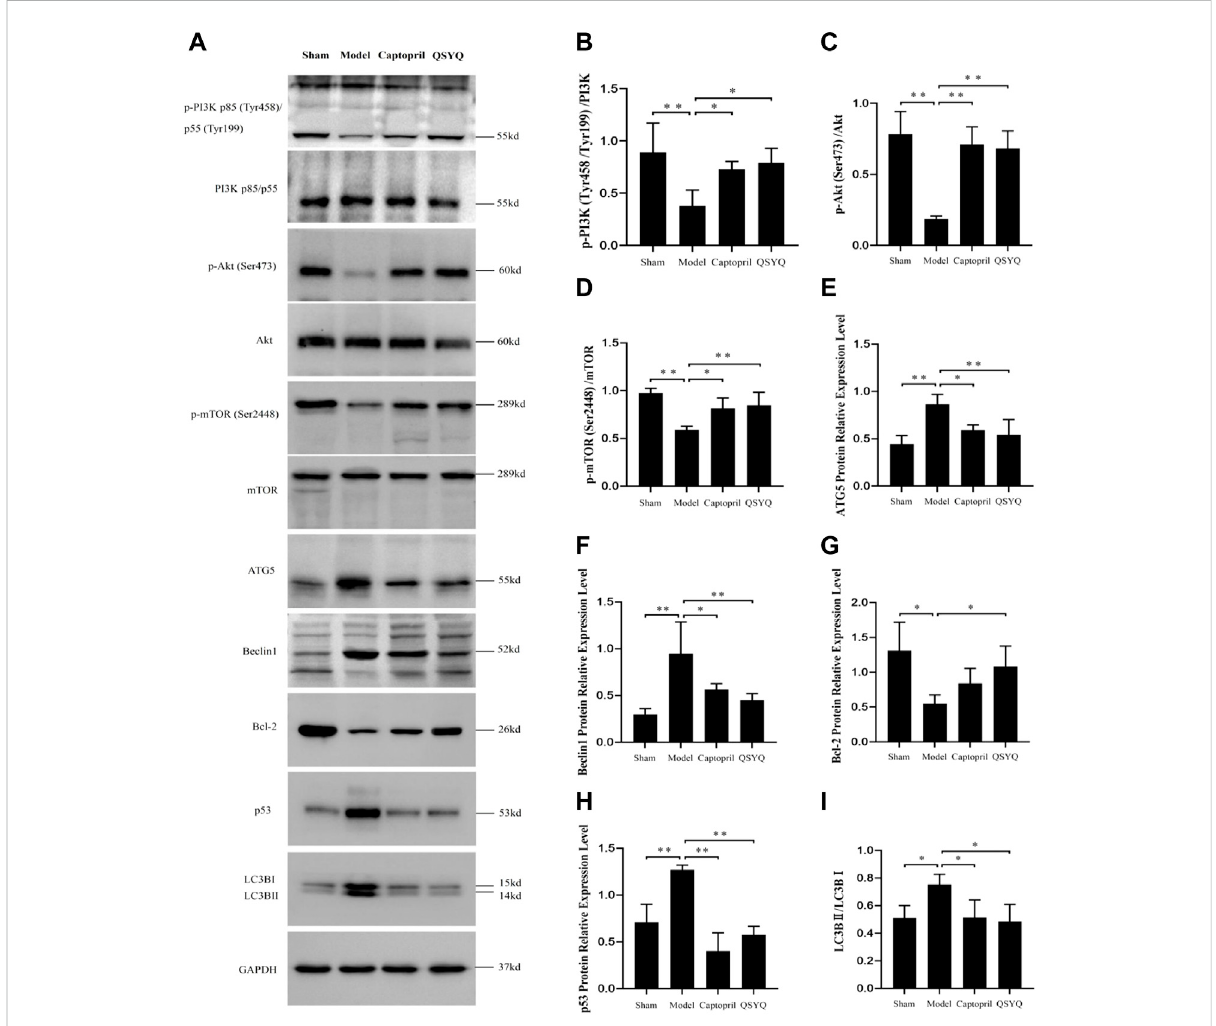
FIGURE 10 Effect of QSYQ on myocardial autophagy-related proteins and PI3K/Akt-mTOR signaling pathway. (A) : Detect the effect of QSYQ on myocardial autophagy-related proteins and PI3K/Akt-mTOR signaling pathway by Western blot in each group. (B – I) : Semi-quantitative analysis of the results, n = 3 per group. *p < 0.05, * * p <